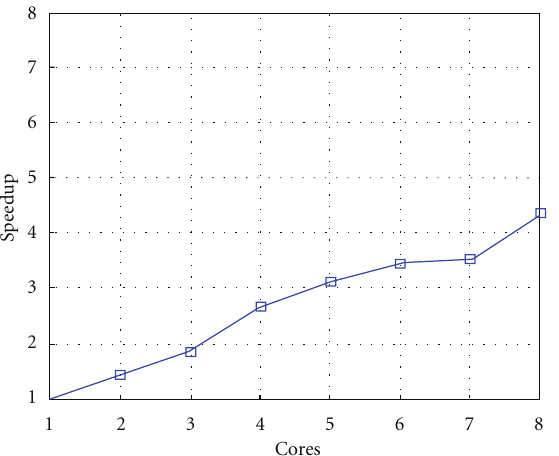
Figure 13: Test 1: Algorithm SI: Speedup versus the number of cores. Δ τ = 0 . 016.